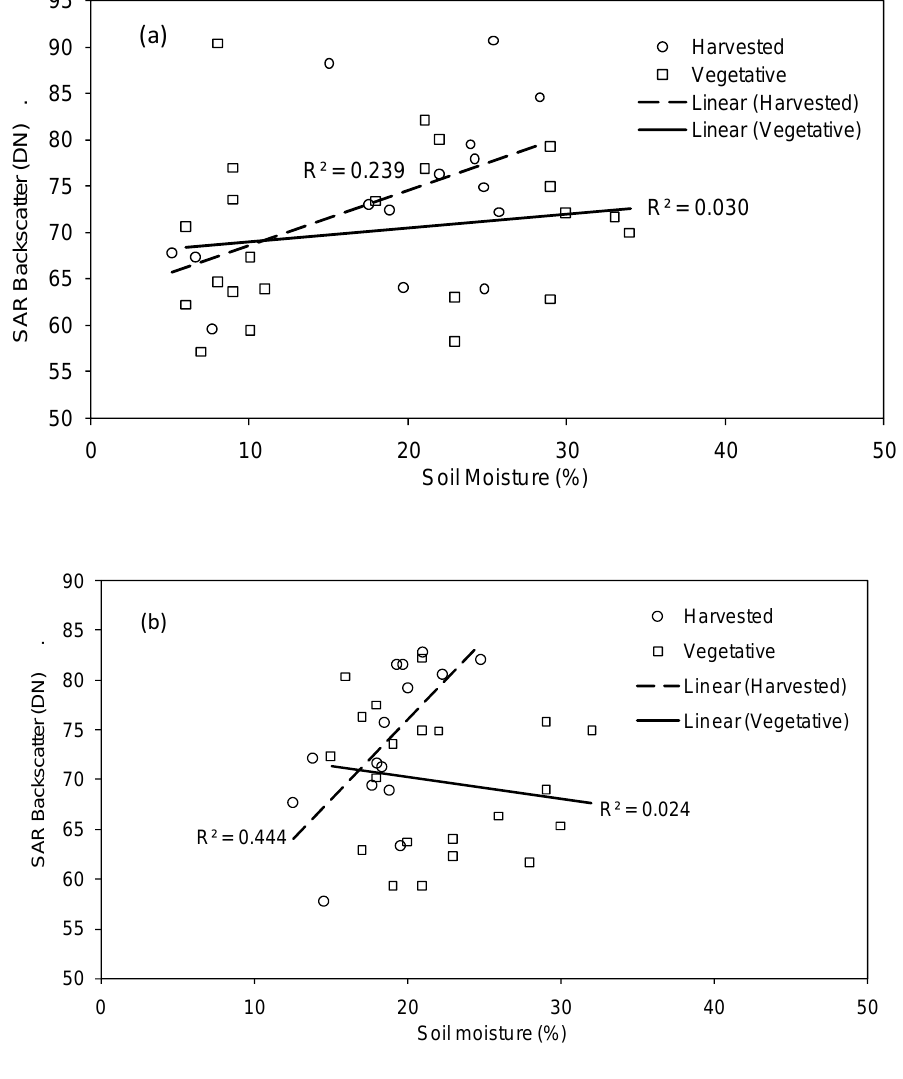
Figure 2. SAR backscatter v/s field measured soil moisture for different vegetation covers for (a) 2 nd July 1997 and (b) 12 th July 1997 data, show better correlation in harvested field than vegetated